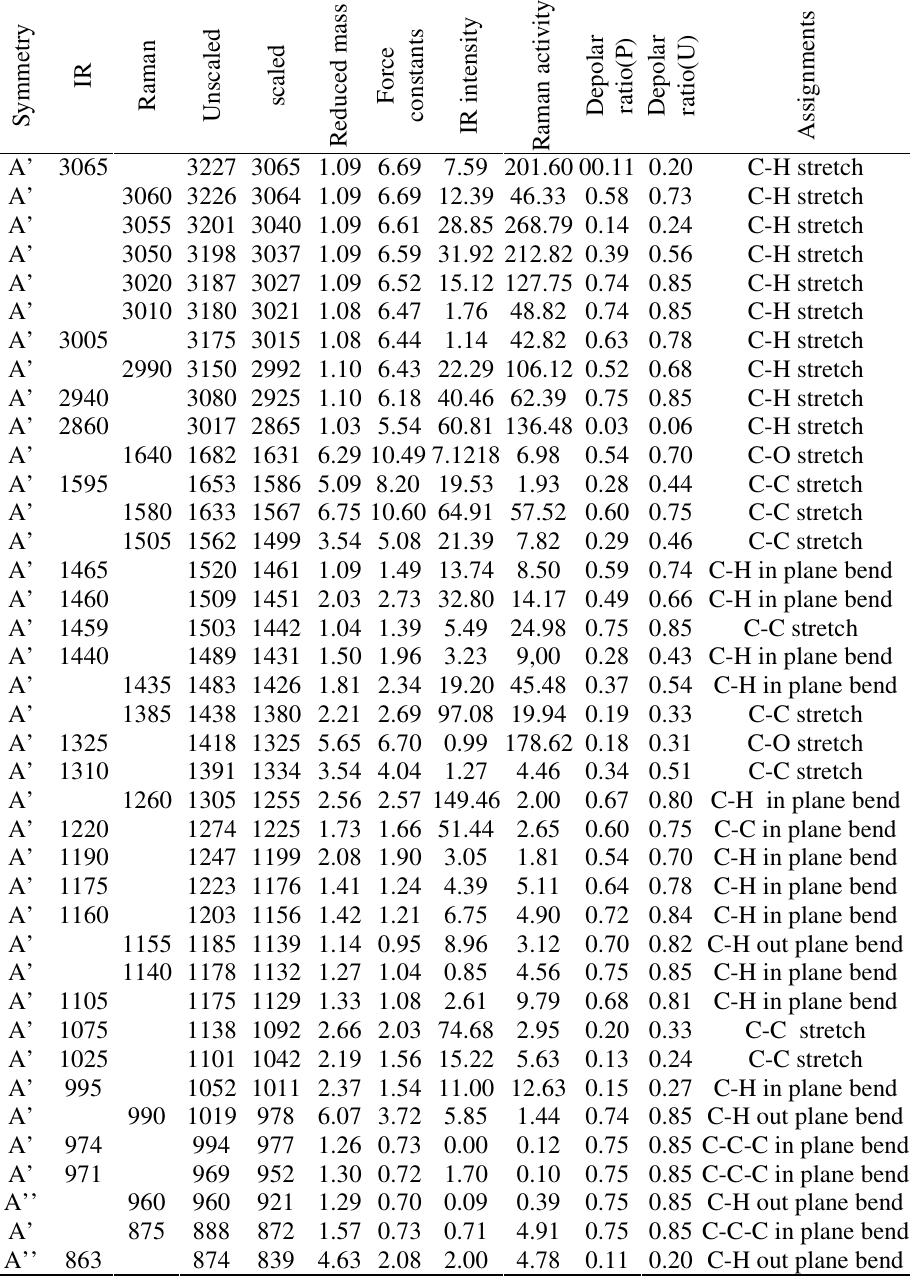
Table 2. Observed and B3LYP 6-31G (d,p) level calculated vibrational frequencies of